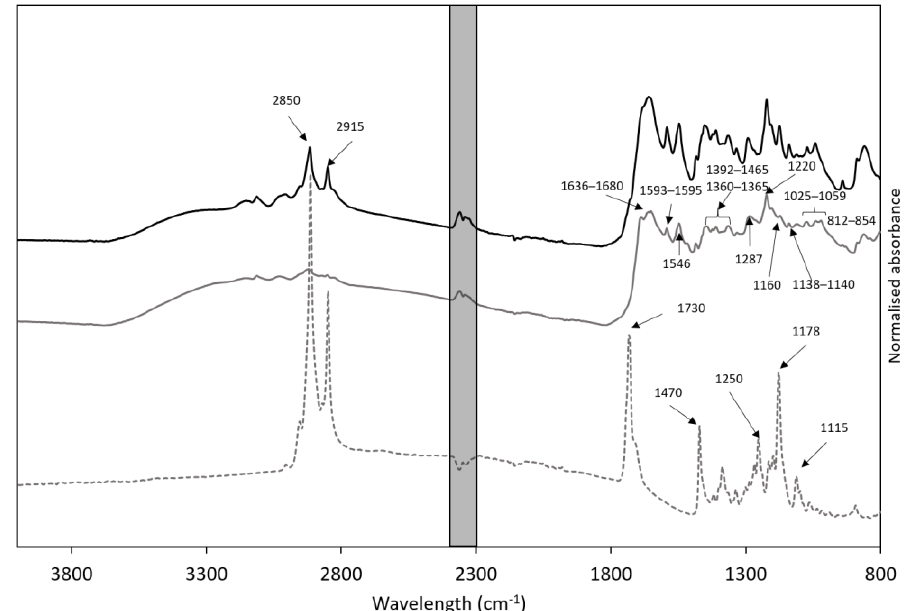
Figure 2. Normalized FT-IR profiles of HEE (hydrothermal ethanol extract, black line), LR-HEE (lipid removed HEE, grey line) and the extracted lipids (dashed line) in the range 800–4000 cm − 1 . Wavenumbers for the key peaks are highlighted, peaks at 2358 and 2340 cm − 1 are related to the atmospheric conditions during measurement (greyed out area).